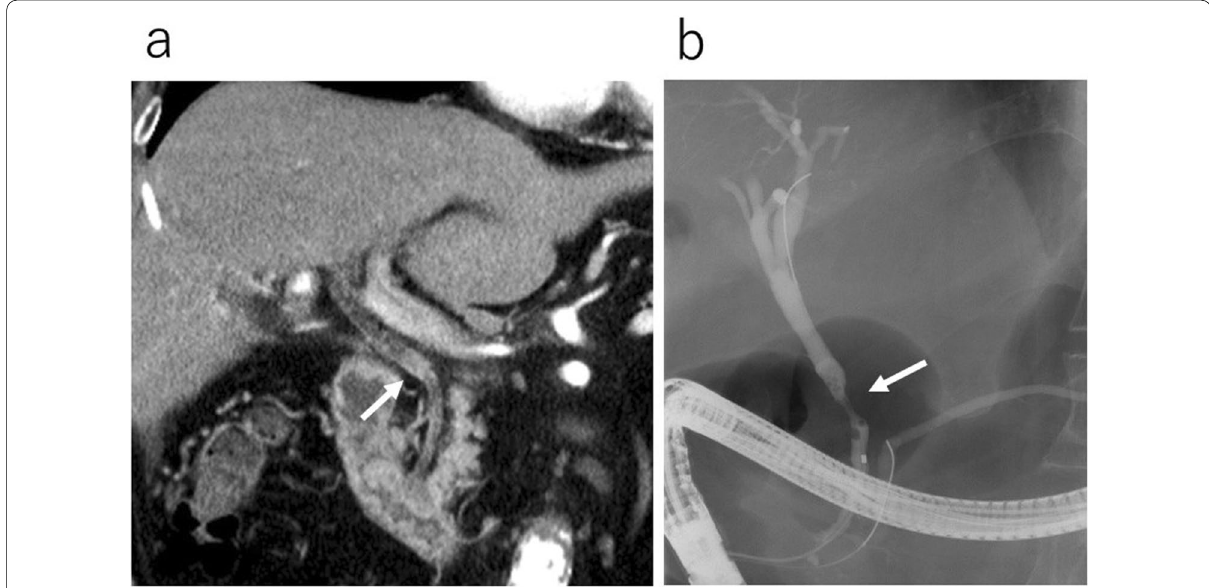
Fig. 1 Image findings of distal bile duct cancer. a Contrast-enhanced CT before PD and after percutaneous transhepatic gallbladder drainage (PTGBD) showing a 2-cm-long mass with contrast enhancement in the central bile duct (arrow distal bile duct (arrow ) without the visualization of the cystic duct. The cytology of the bile duct brush and bile cytology were both class ←